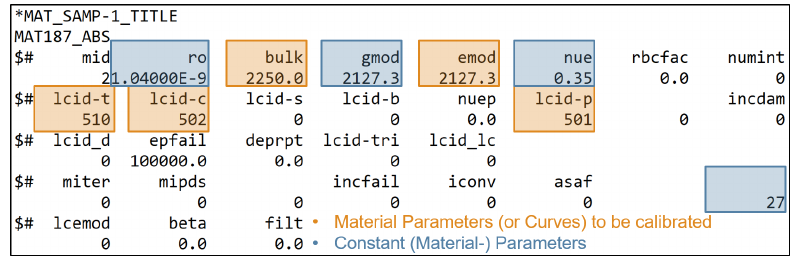
Figure 1. Exemplary illustration of the material card MAT_187_SAMP-1 used in this work.